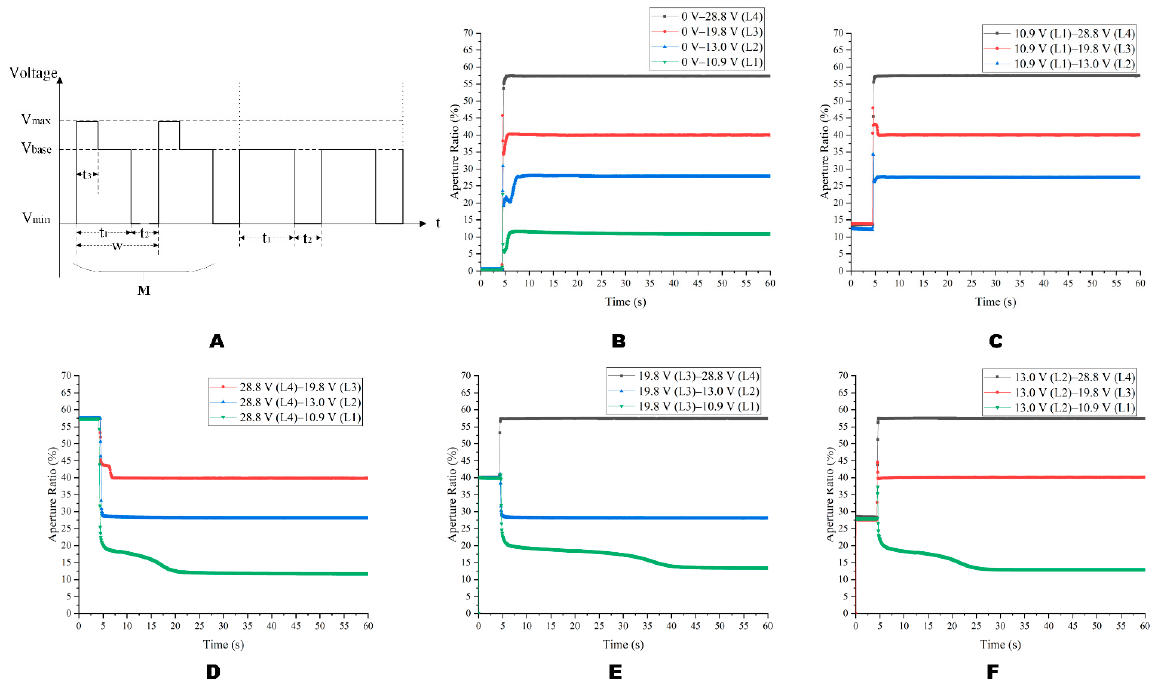
Figure 15. The diagram of the aperture ratio switching between four gray scales under the multi-DC driving waveform. ( A ) The multi-DC driving waveform diagram for gray scale consistency. ( B ) The curve of the aperture ratio when 𝑉 (cid:3029)(cid:3028)(cid:3046)(cid:3032) changed from 0 V to L1~L4. ( C ) The curve of the aperture ratio when the voltage of the 𝑉 (cid:3029)(cid:3028)(cid:3046)(cid:3032) changed from L1 to L2~L4. ( D ) The curve of the aperture ratio when the 𝑉 (cid:3029)(cid:3028)(cid:3046)(cid:3032) changed from L2 to L1, L3, and L4. ( E ) The curve of the aperture ratio when the 𝑉 (cid:3029)(cid:3028)(cid:3046)(cid:3032) changed from L3 to L1, L2, and L4. ( F ) The curve of the aperture ratio when the 𝑉 (cid:3029)(cid:3028)(cid:3046)(cid:3032) changed from L4 to L1~L3. 3.4. Multi-DC Driving Waveform Applied to TFT-EWD When the driving waveform was applied to the TFT-EWD, the parameters of the driving waveform could change by capacitance in the driving substrate of the EWD. Therefore, the driving waveform parameters in the TFT-EWD were set as follows: 𝑓 = 62.06 Hz, 𝑡 (cid:2870) = 61.38 us, 𝑡 (cid:2871) = 9.29 ms, 𝑉 (cid:3040)(cid:3028)(cid:3051) = 20 V, 𝑉 (cid:3040)(cid:3036)(cid:3041) = 0 V, 𝑉 (cid:3029)(cid:3028)(cid:3046)(cid:3032) = 15 V. The driving waveform was taken as a common voltage and input into the top ITO substrate. The co- ordination of the source signal and the gate signal in the TFT substrate controls the voltage of the corresponding pixel of the EWD, thereby displaying the grayscale. As shown in Figure 16, each driving waveform was applied to the TFT-EWD to display multi levels of the gray scale. As could be seen in Figure 16A, pixels could not be driven when low gray scales were applied by a single DC driving waveform. As shown in Figure 16B, compared with the DC driving waveform, more gray scales could be displayed with a multi-DC driving waveform. As shown in Figure 16B, in the image of the area marked by the red box, the driving waveform proposed in this paper displays four more gray levels than the DC driving waveform. In the image of the area marked by the blue box, the grayscale image displayed more evenly and clearly with a proposed driving waveform.